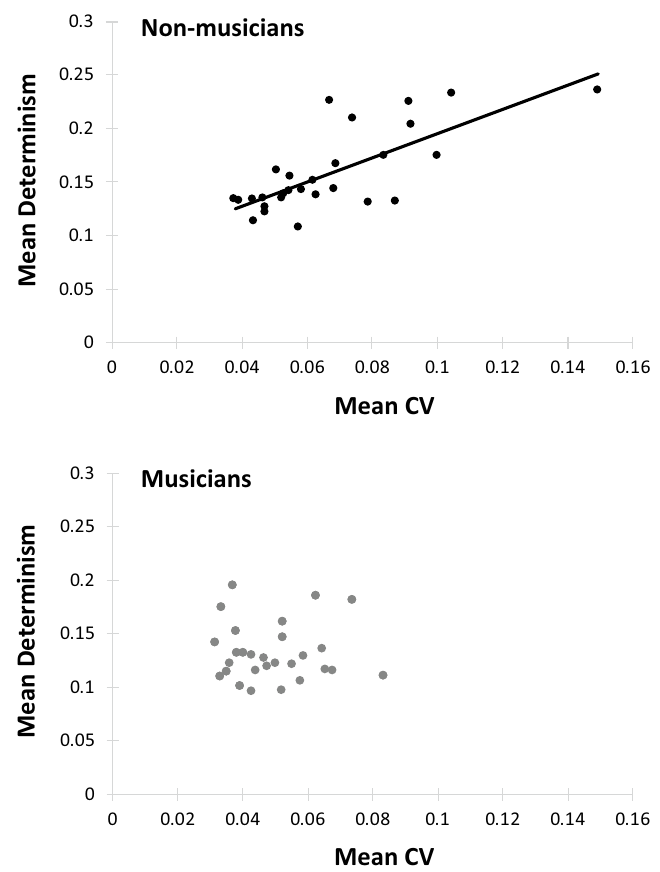
Figure 6. Solo performances: Mean CV (standard deviation / mean ITI) by mean determinism. Each dot represents one participant. Top: Non-musician group (r (26) = .74, p < .001). Bottom: Musician group (r (26) = − .003, p =